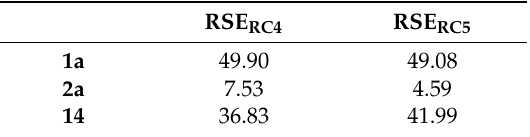
Scheme 5. Homodesmotic and hyperhomodesmotic reactions used for the evaluation of the RSE in parent oxaphosphirene 1a . Table 2. Computed (CCSD(T)/def2-TZVPP//B3LYP-D3/def2-TZVP) RSE (kcal/mol) using homodesmotic (RC4) or hyperhomodesmotic (RC5) reaction schemes.